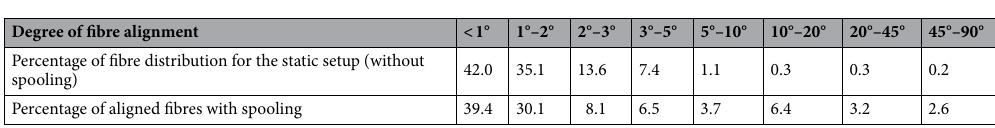
Table 2. Distribution of fibre alignment achieved for 12 wt/vol% PAN in DMSO using the Vee-shield fixture with and without spooling. The standard deviations for the whole datasets for with and without spooling were 12.13 and 4.14 respectively.